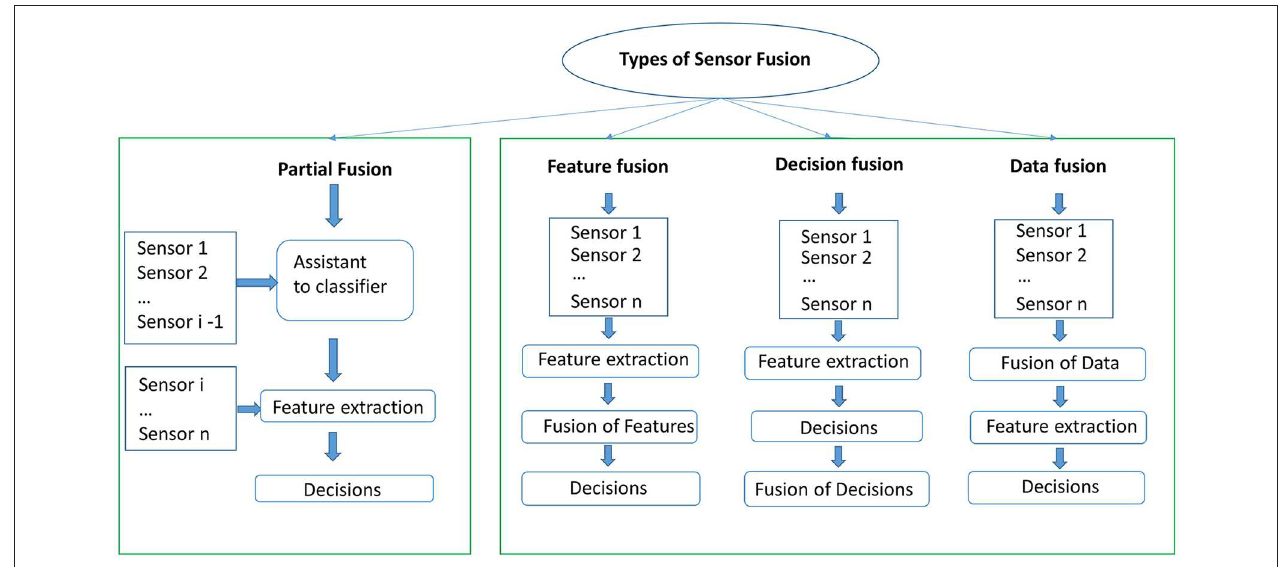
FIGURE 7 | Four kinds of sensor fusion methods including partial fusion, feature fusion, decision fusion, and data fusion. Partial fusion means that a subset of sensors are deployed to make decisions, while the other types of fusion techniques use all sensors as